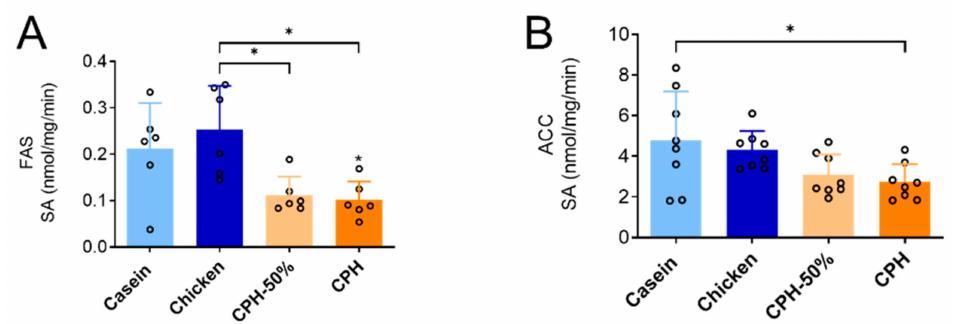
Figure 3. Dose effect on hepatic enzyme activity in Wistar rats fed high-fat diets with casein, chicken whole protein or different doses of chicken protein hydrolysate (CPH) for 12 weeks. In the 50% CPH group, 50% of the protein source was casein. ( A ) Fatty acid synthase (FAS) activity, and ( B ) acetyl-CoA carboxylase (ACC) activity was measured in frozen liver homogenates. Means values with standard deviation are given, and individual values are indicated by circles ( n = 6–8). Significant difference was determined by one-way ANOVA with Tukey’s multiple comparisons test between all diet groups (* p < 0.05).